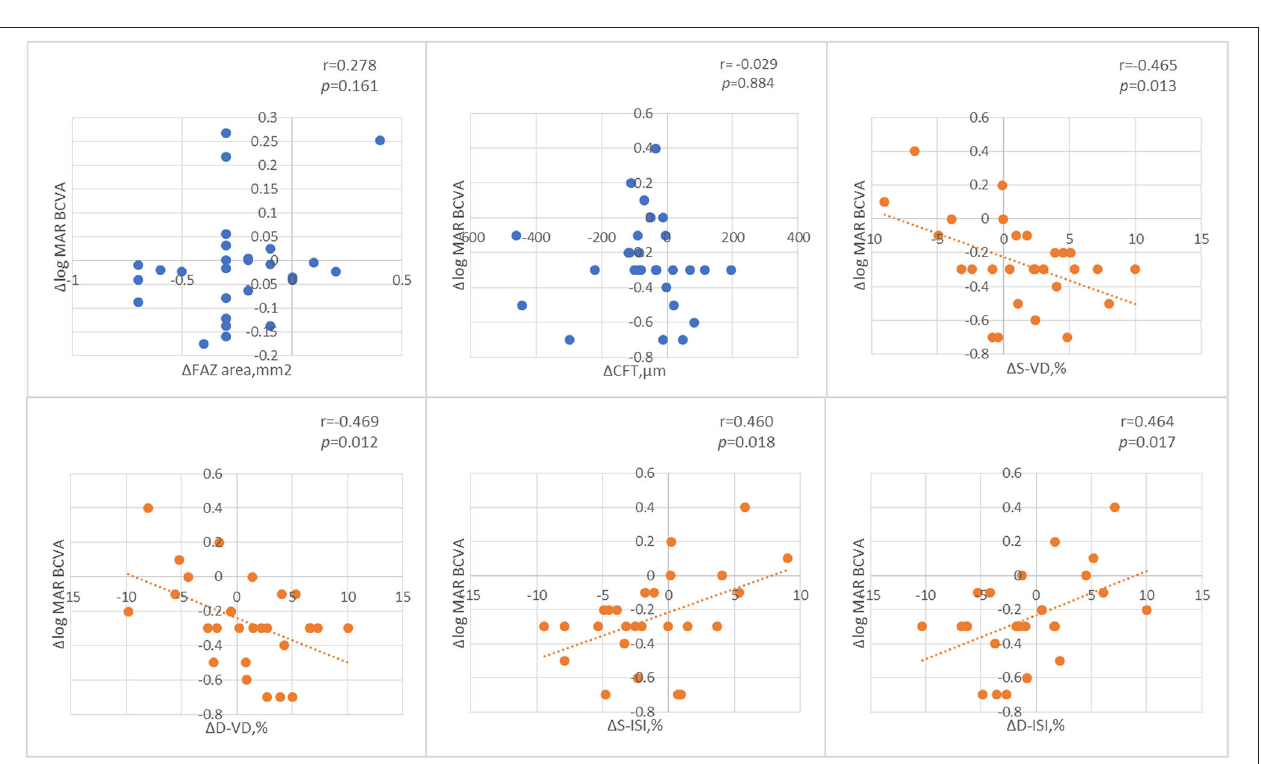
FIGURE 7 | The Pearson correlation analysis of the changes of best corrected visual acuity (BCVA) and macular perfusion indexes.